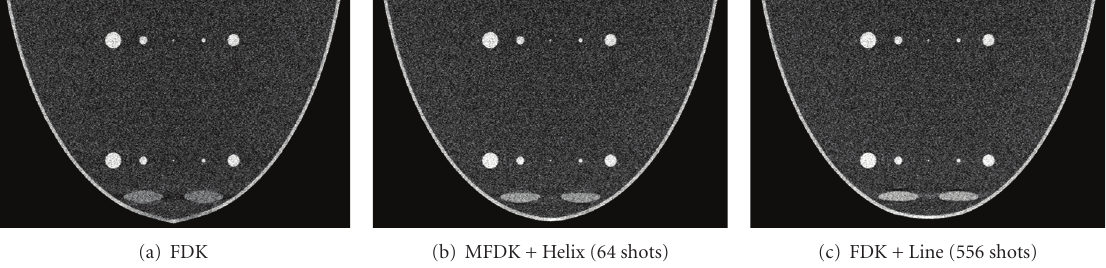
Figure 10: The Central sagittal image comparison between di ff erent scanning schemes based on simulated quantum noise in the projection data. (a) Circular FDK; (b) MFDK + Helix reconstruction (64 shots for helical scan); (c) FDK + Line reconstruction (556 shots for line